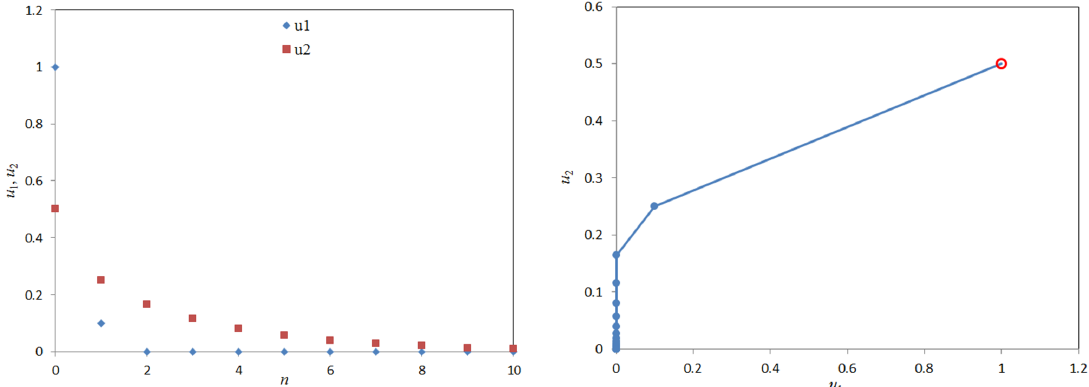
Figure 3. Dependencies 𝑢 (cid:2869) (cid:4666)𝑡(cid:4667) and 𝑢 (cid:2870) (cid:4666)𝑡(cid:4667) ( left ) and the phase trajectory of the worker ‐ employer conflict ( right ) for 𝑢 (cid:2869)(cid:4666)(cid:2868)(cid:4667) (cid:3404) 1; 𝑢 (cid:2870)(cid:4666)(cid:2868)(cid:4667) (cid:3404) 0.5; 𝑘 (cid:2869)(cid:2869) (cid:3404) 0.1; 𝑘 (cid:2870)(cid:2870) (cid:3404) 0.2; 𝑘 (cid:2869)(cid:2870) (cid:3404) 0.3; and 𝑘 (cid:2870)(cid:2869) (cid:3404) 0.8 ( 𝜆 (cid:2869) (cid:3404) 0.737; 𝜆 (cid:2870) (cid:3404) 0.163). The discrepancy 𝑢 (cid:2869) corresponds to the worker while the discrepancy 𝑢 (cid:2870) corresponds